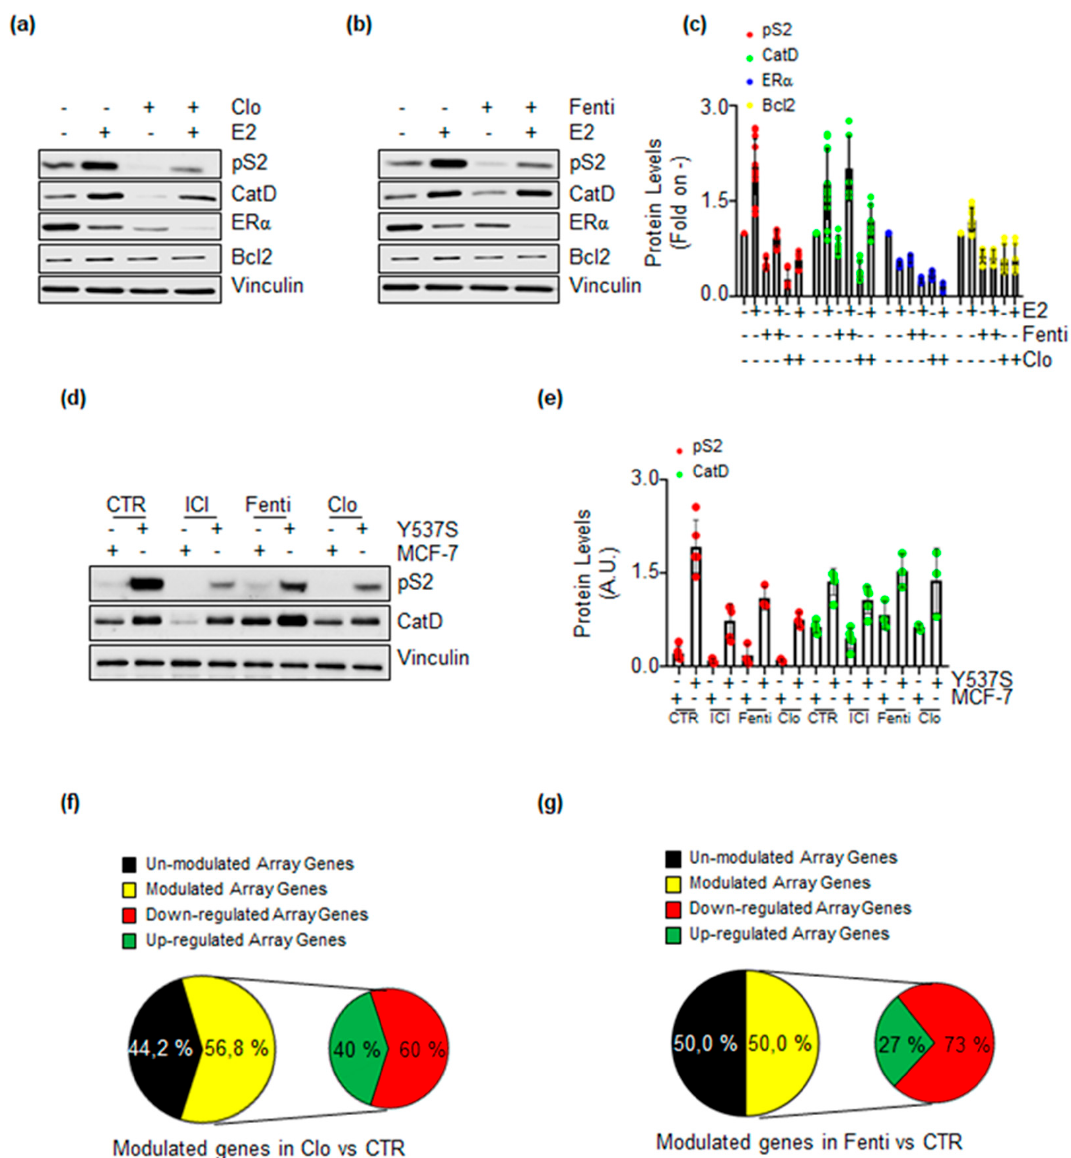
Figure 6. The impact of clotrimazole and fenticonazole on ER α -dependent gene expression. Western blotting analysis of ER α , presenilin 2 (pS2), cathepsin D (Cat D), and Bcl-2 expression in MCF-7 cells pre-treated with clotrimazole (Clo 10 μ M) ( a ) and fenticonazole (Fenti 10 µ M) ( b ) for 72 h. ( c ) Densitometric analysis relative to panel ( a , b ). The loading control was